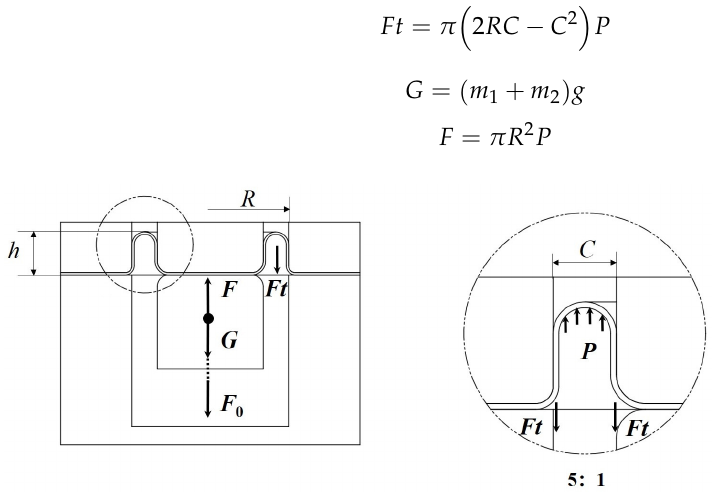
Figure 4. Schematic diagram of axial force analysis of the HSU.